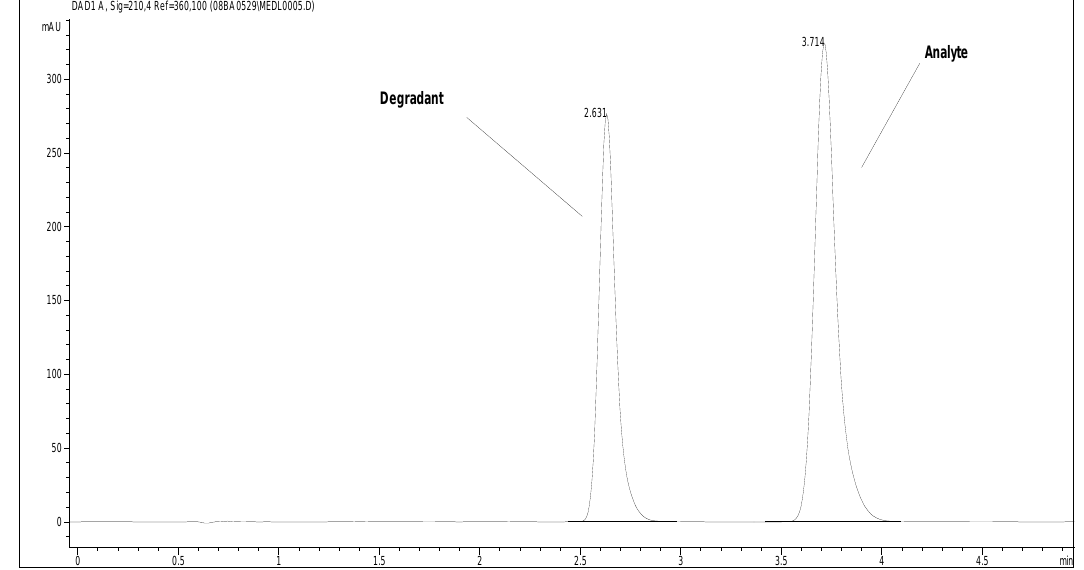
Figure 4. An example chromatogram of a stability-indicating HPLC method that evaluates the analyte and degradant peaks that are fully resolved from one